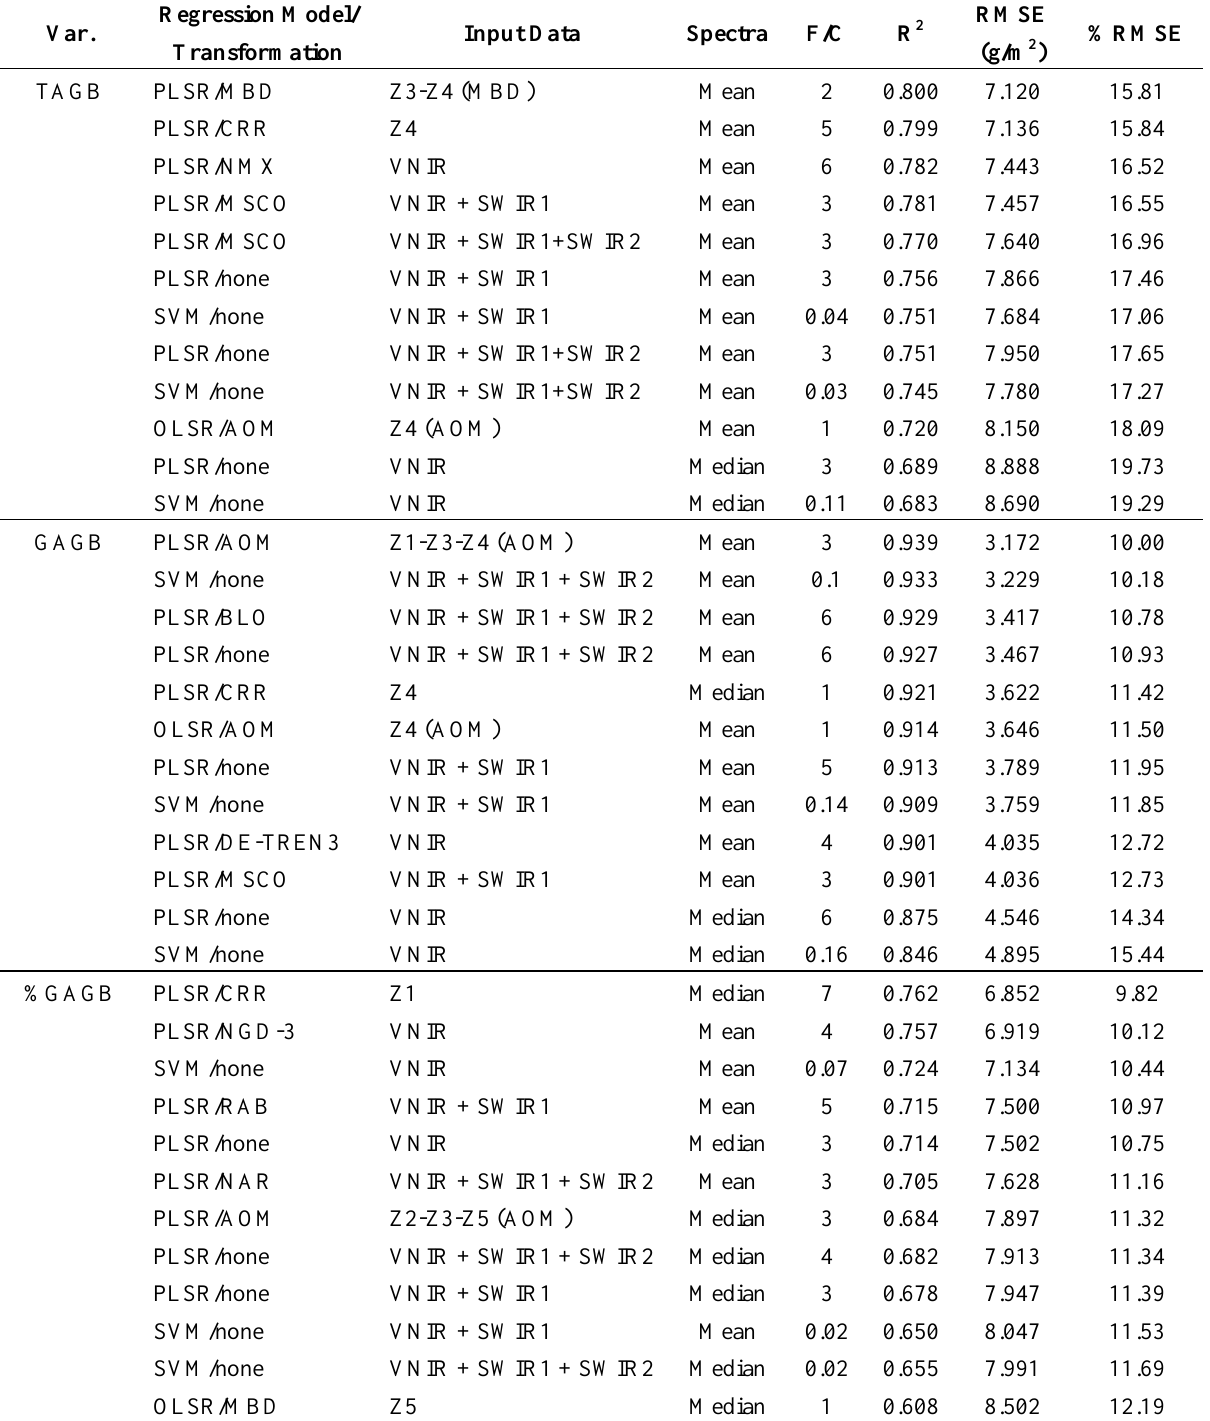
Table 6. Performance of PLSR, SVM and OLSR and spectral transformations for predicting total (TAGB), green (GAGB) and percentage of green (%GAGB) grass/clover